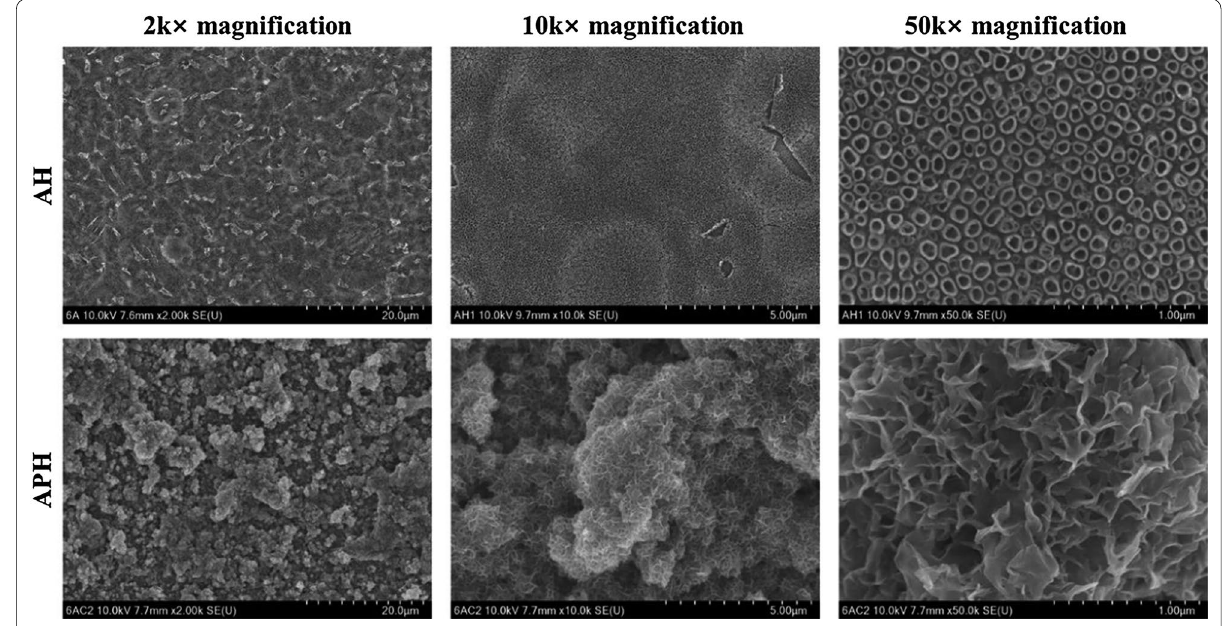
Fig. 3 FE‑SEM images of the surface of a Ti–6Al–4V ELI alloy plate specimen of the APH group immersed in SBF for 1 days